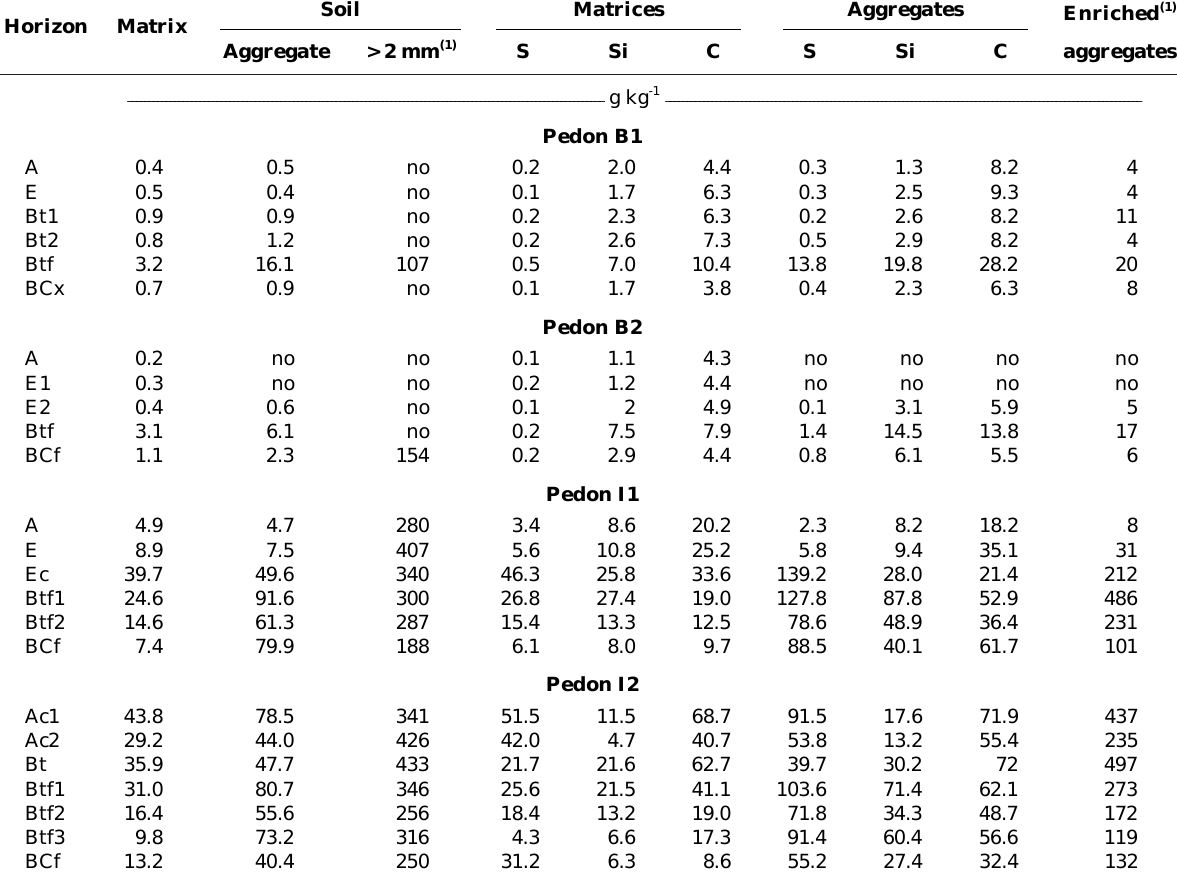
Soil Matrices Aggregates Enriched (1)